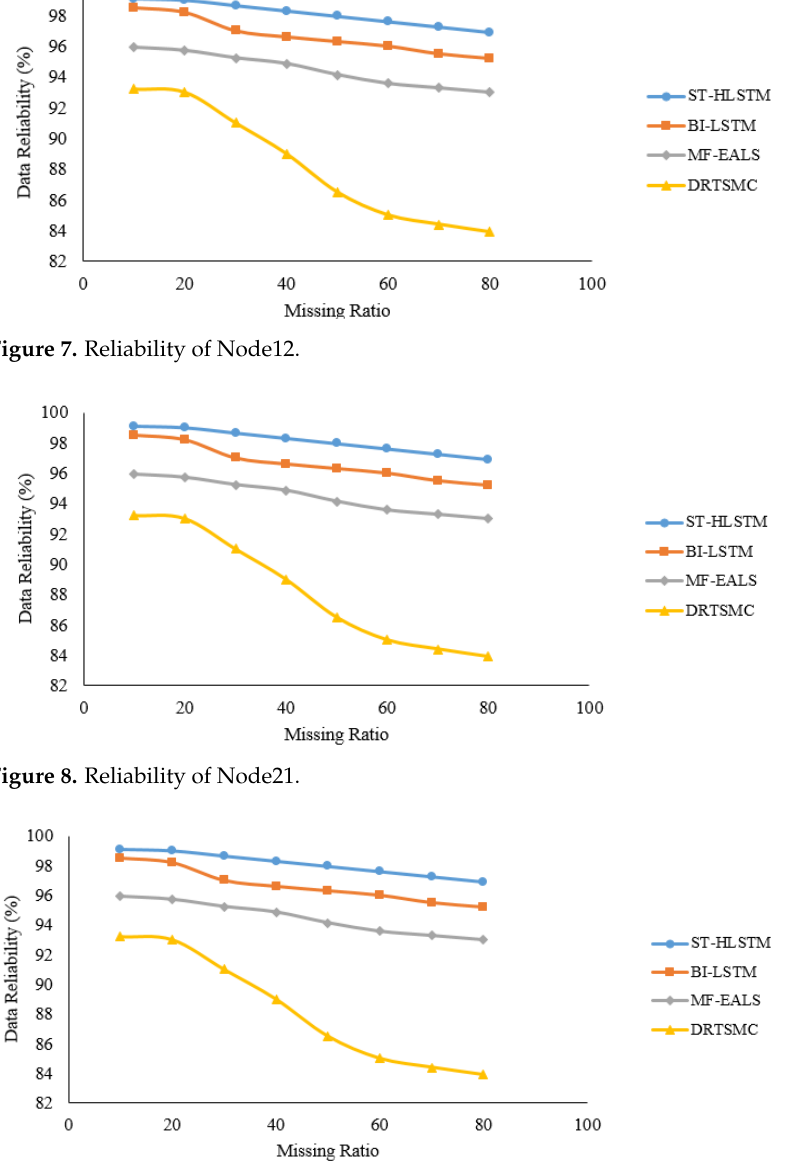
Figure 9. Reliability of